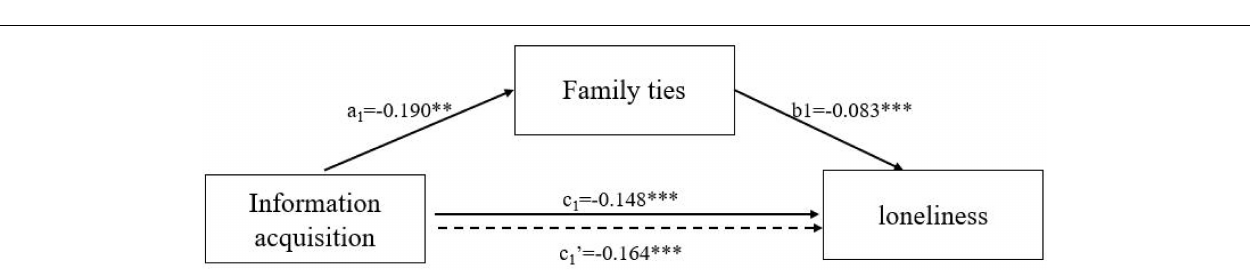
FIGURE 1 | The mediating effects of family ties in the association between interpersonal communication and loneliness. *** p < 0.001, ** p < 0.01, * p < 0.05.